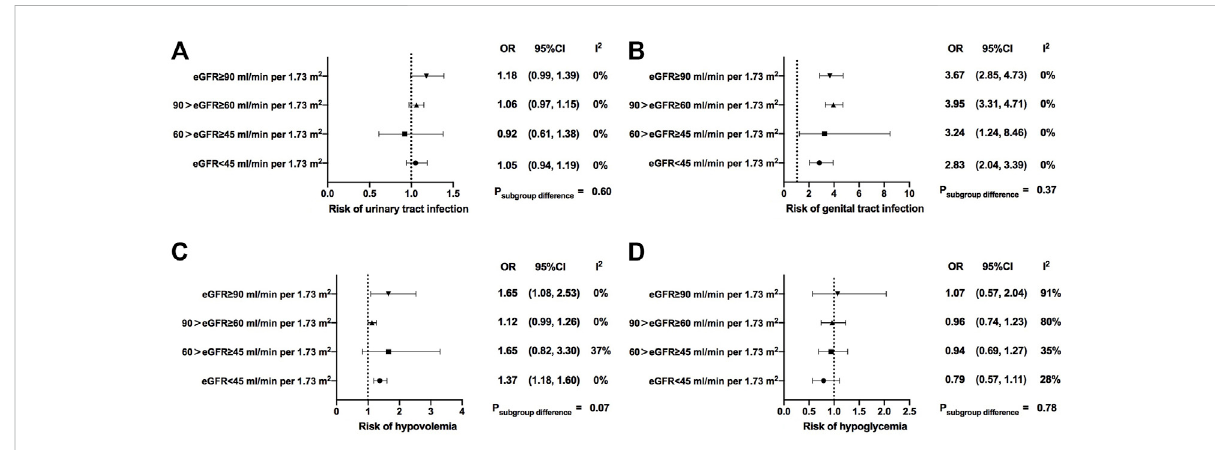
FIGURE 4 Safety of SGLT2i treatment in patients with different levels of renal function. eGFR, estimated glomerular fi ltrationrate; OR, odds ratio; 95% CIs, 95% con fi dence